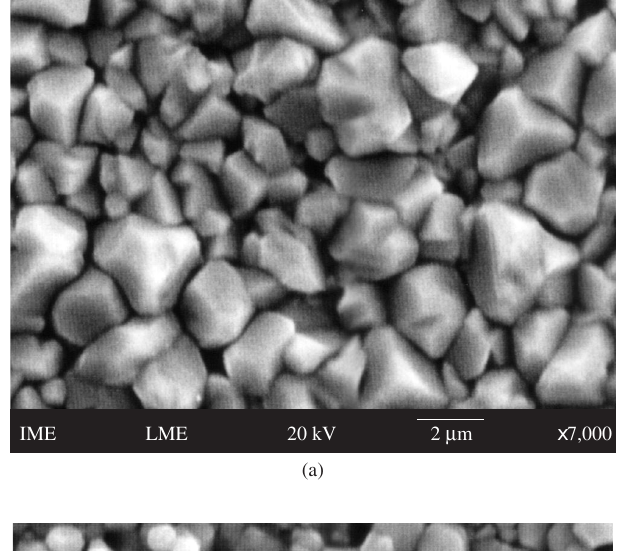
Figure 2. SEM images of CdTe films deposited at T and P = 10 Torr: a) 0% O mix